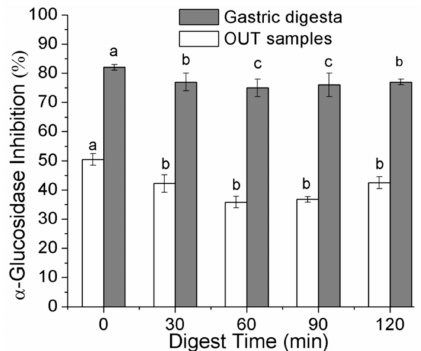
Figure 3. Percent α -glucosidase inhibition for gastric digesta and OUT samples at different time points during in vitro gastrointestinal digestion. The mean values reported at each digestion stage-those with a common superscript (a–c) are not significantly different from each other ( p < 0.05). Data are means of three independent determinations ±